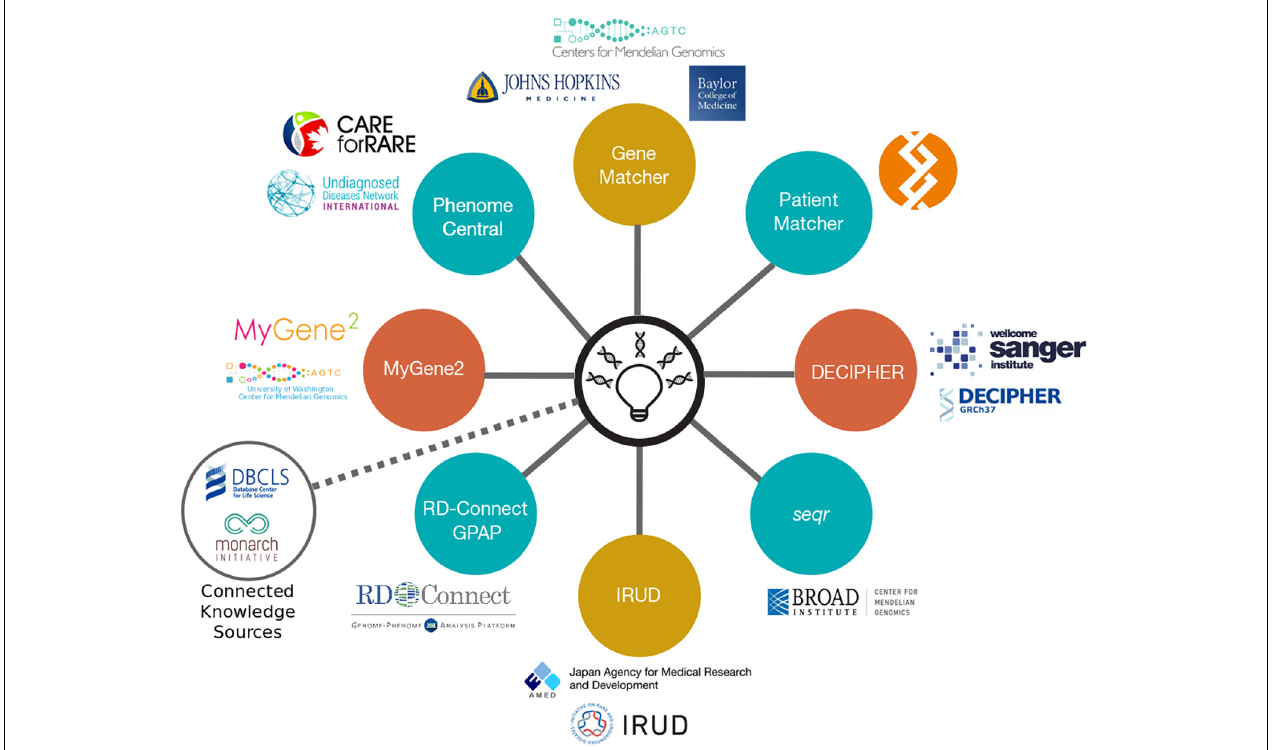
FIGURE 1 | The MME API and its connected nodes. MME uses a federated network of nine connected nodes. Image taken from